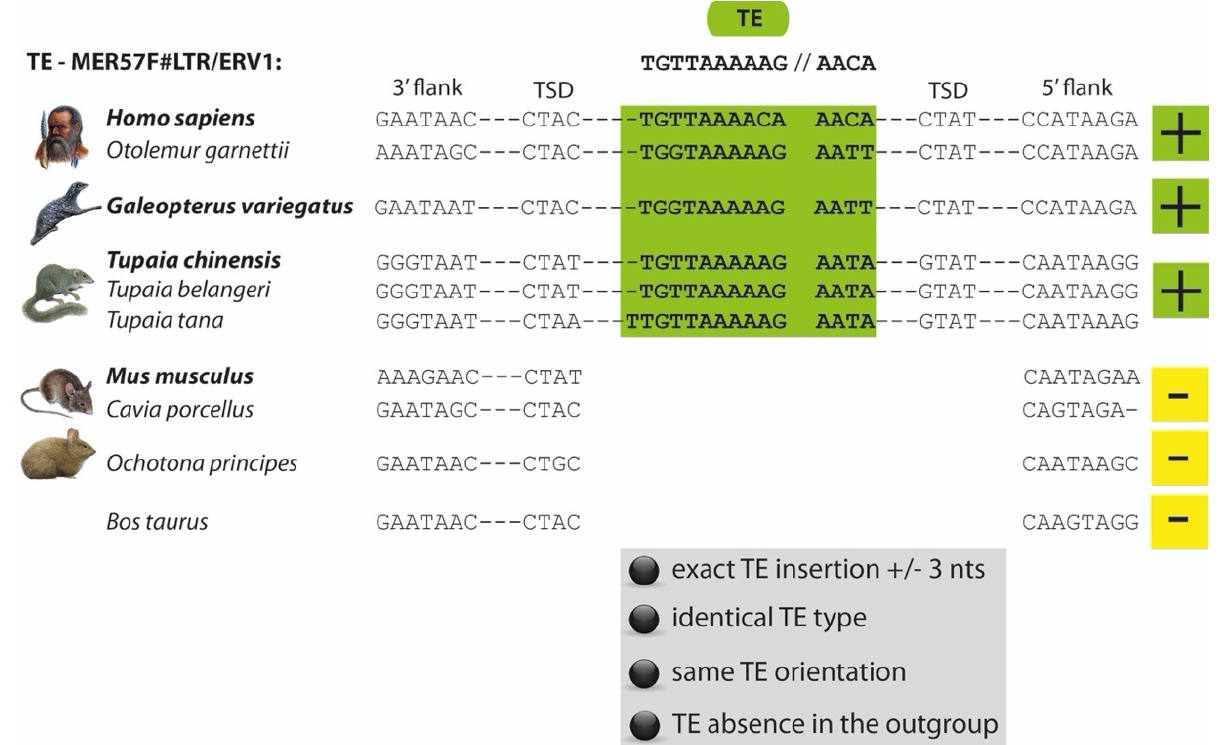
Figure 2. Structure of an example alignment for a MER57F#LTR/ERV1 TE (marker Euarch187). The presence of the TE is shown in green and indicated by (+). The absence state is displayed in yellow and indicated by ( − ). TSD indicates the TE-flanking tandem sequence duplications that appear during the insertion process of elements and are hallmarks of orthology. The stringencies of selecting a diagnostic position are given below the sequences.